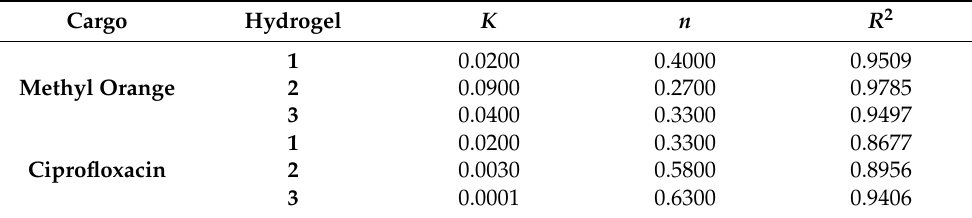
Table 5. Release coefficients of the Korsmeyer–Peppas model obtained for methyl orange and ciprofloxacin release profiles in hydrogels 1 , 2 , and 3 . Cargo Hydrogel K n Methyl